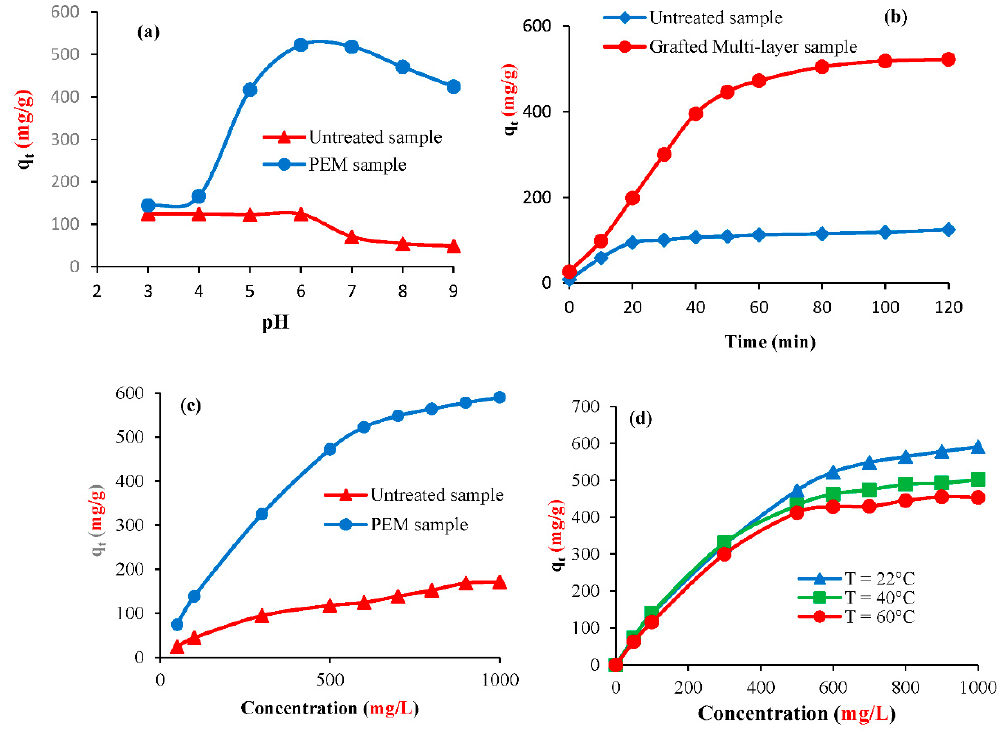
Figure 6. ( a ) Effect of pH on methylene blue adsorption (C 0 = 600 mg/L, t = 120 min), ( b ) effect of time, ( c ) effect of initial dye concentration, and ( d ) effect of temperature.